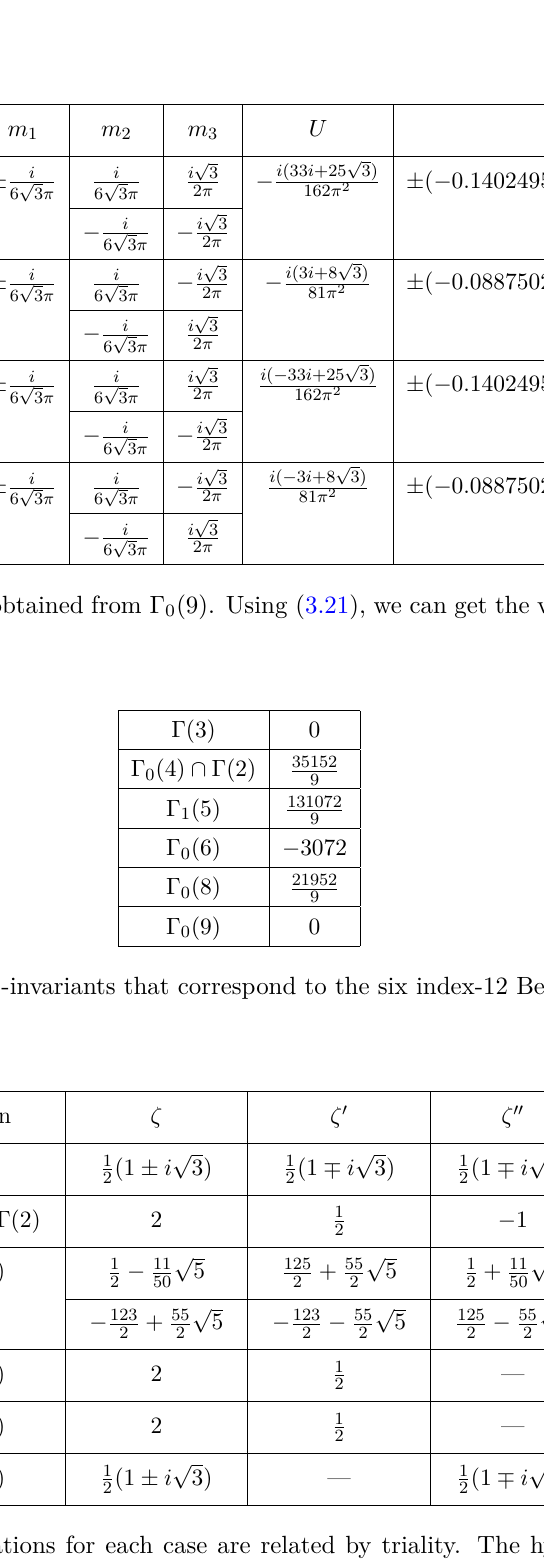
(6) and Γ (8) ) or does not satisfy the trans- 0 0